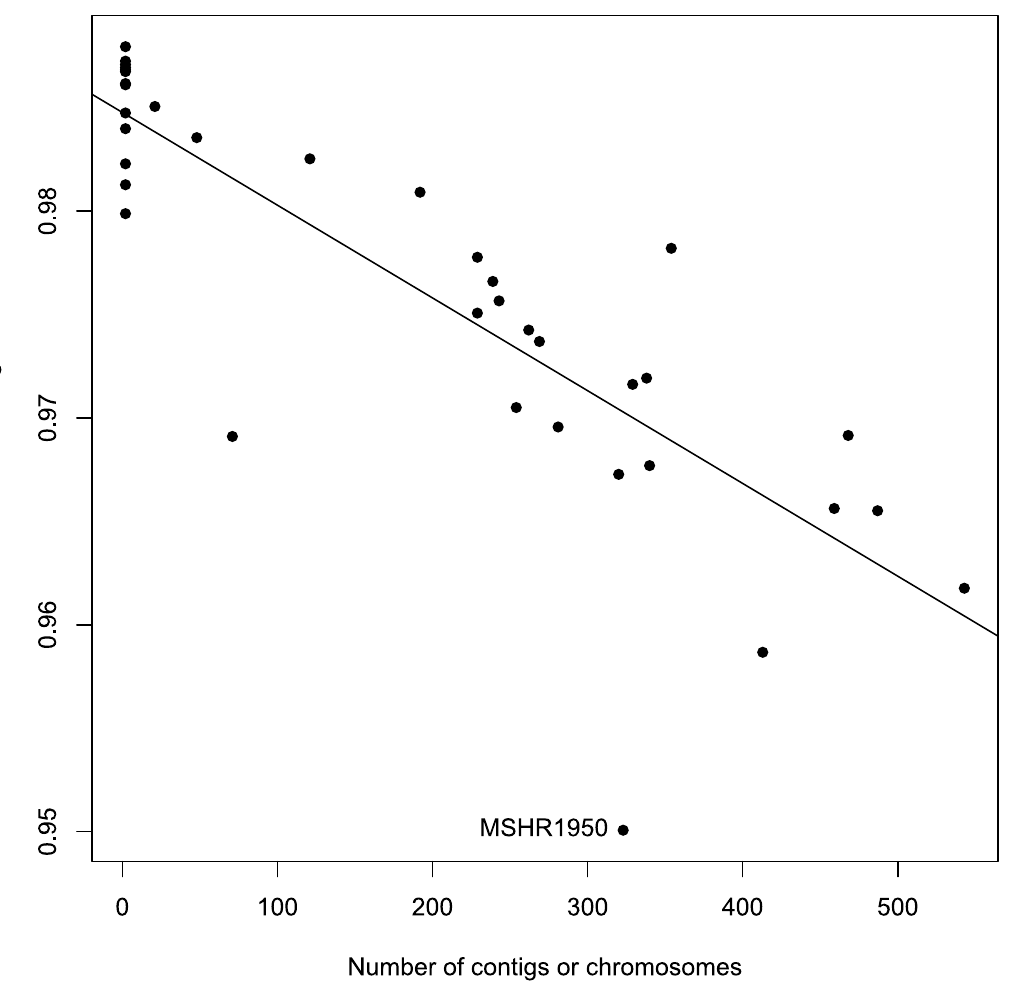
Fig 7. Conservation of gene order among pairs of genomes. Average conservation of gene order for each genome is negatively related to the number of